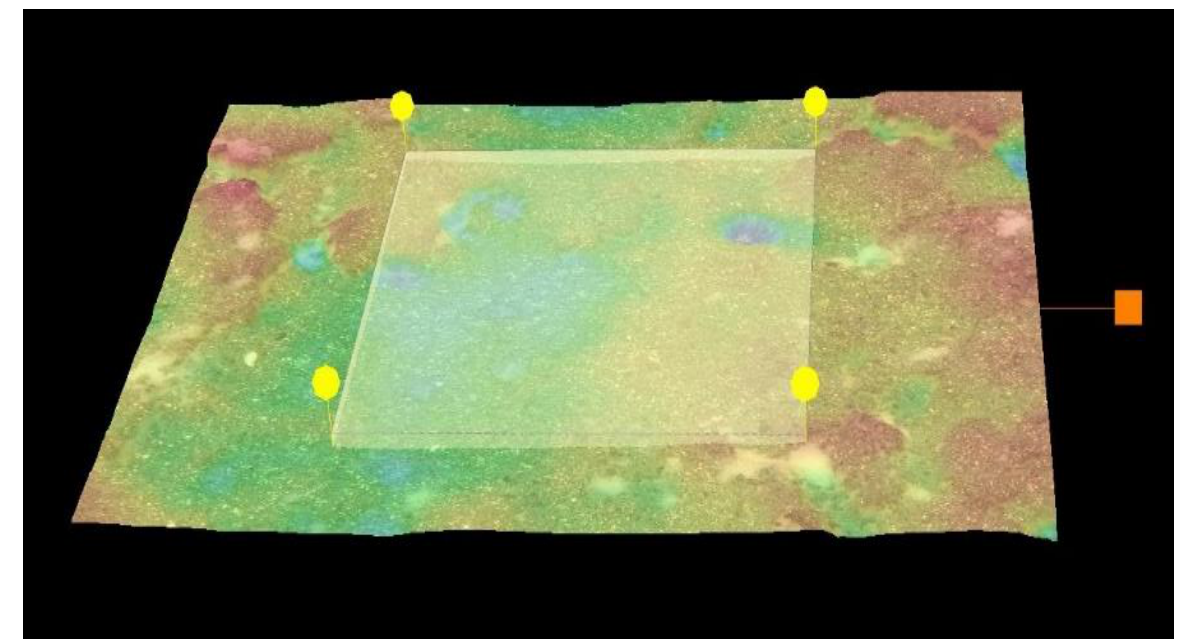
Figure 3. Volume measurement in optic microscope VHX-950F (Keyence).